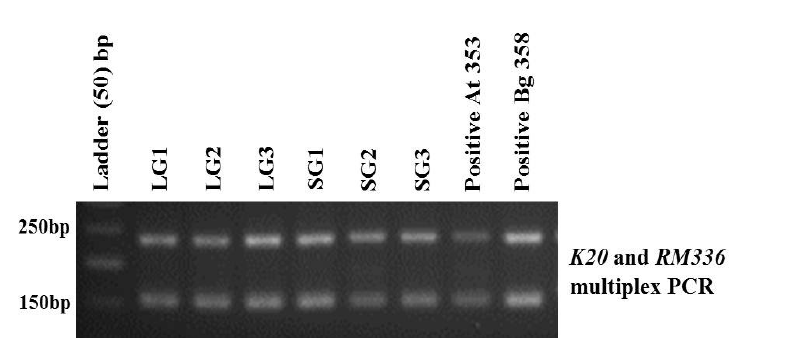
Figure 5: Agarose gel image of the multiplex PCR with K20 marker and RM336 markers (2.5% agarose gel electrophoresis). The names of the microsatellite markers are indicated on the right side of the Figure and the key band sizes of the ladder are indicated on the left side. The 50bp ladder was used as the size standard. Names of the market samples are given on the top. Three long grain (LG) (Nadu) and three short grain (SG) (Samba) samples were used for the analysis. The leaf DNA of the rice varieties At 353 (LG type) and Bg 358 (SG type) were used as the positive controls in multiplex PCR.